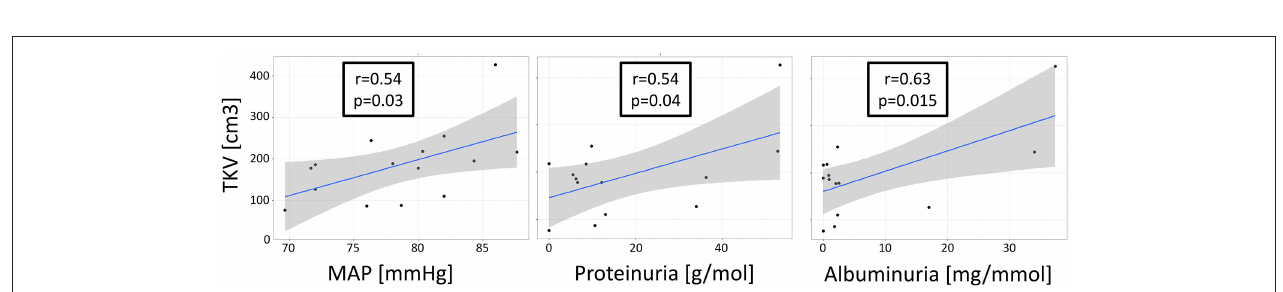
FIGURE 2 | Association between uNGAL and parameters of renal impairment. No association shown between urinary NGAL (uNGAL) and Total Kidney Volume (TKV), mean arterial pressure (MAP), proteinuria [g/mol], or albuminuria [mg/mmol].